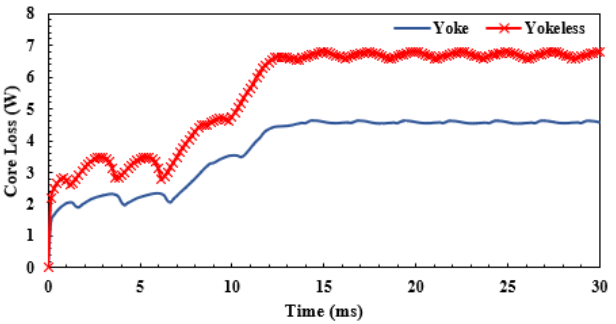
Figure 12. Core loss comparison in DARF-PMVM.